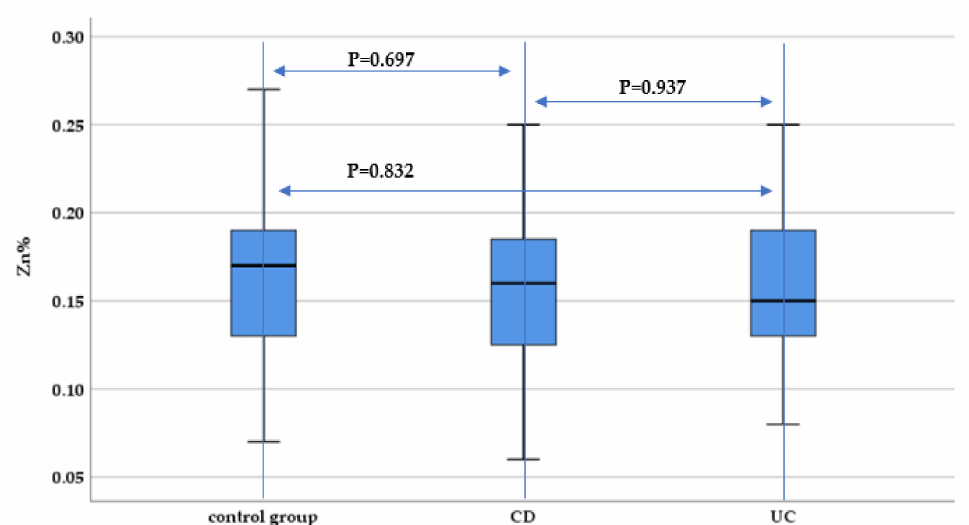
Figure 7. Evaluation of hair zinc concentration (Zn%) between IBD subtypes (UC and CD) and the control group. Hair selenium concentration was decreased both among UC and CD patients com- pared to the control group ( p = 0.002 and p < 0.001, respectively). However, there was no statistically significant difference between selenium hair concentration between UC and CD patients ( p = 0.952) (Figure 8).